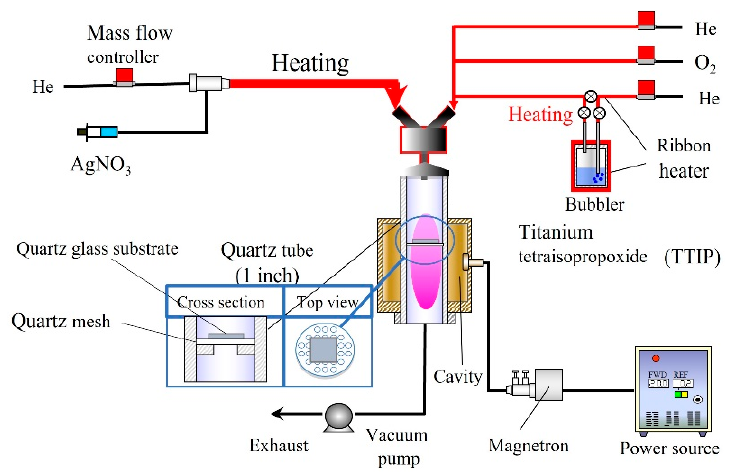
Figure 7. Schematic describing the fabrication process of the plasma-enhanced chemical vapor deposition method .